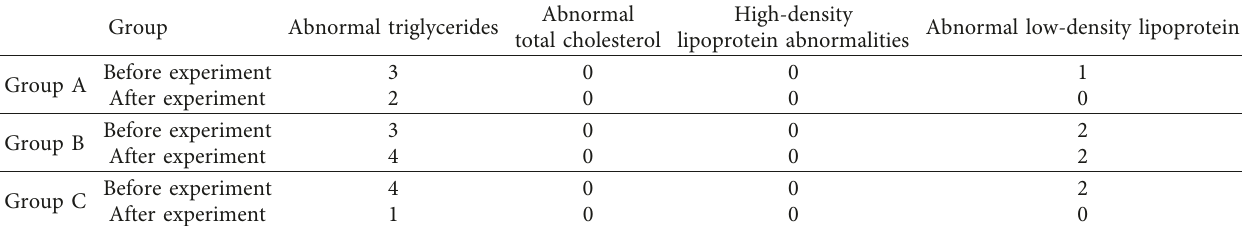
Table 4: Comparison of the number of abnormal blood lipids in each group before and after the experiment. Abnormal Group Abnormal triglycerides total